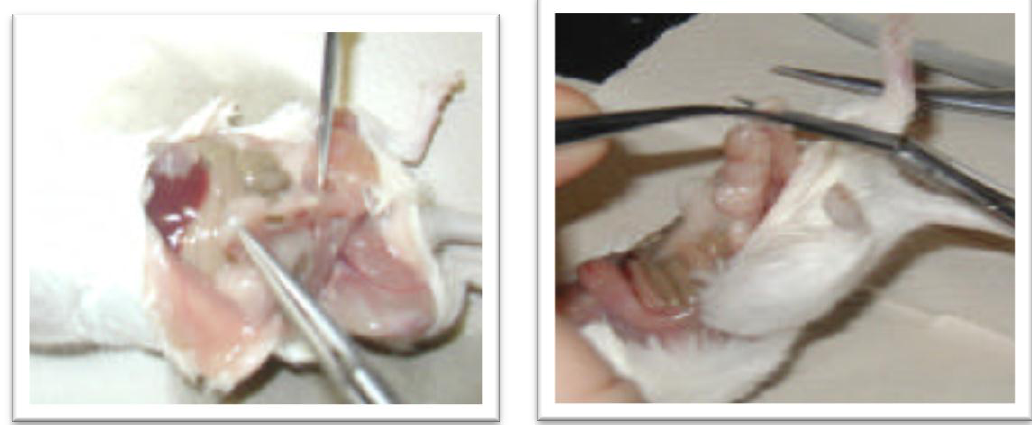
Figure 2: Finding the Caudal Epididymis Figure 3: Cutting out the Caudal Epididymis